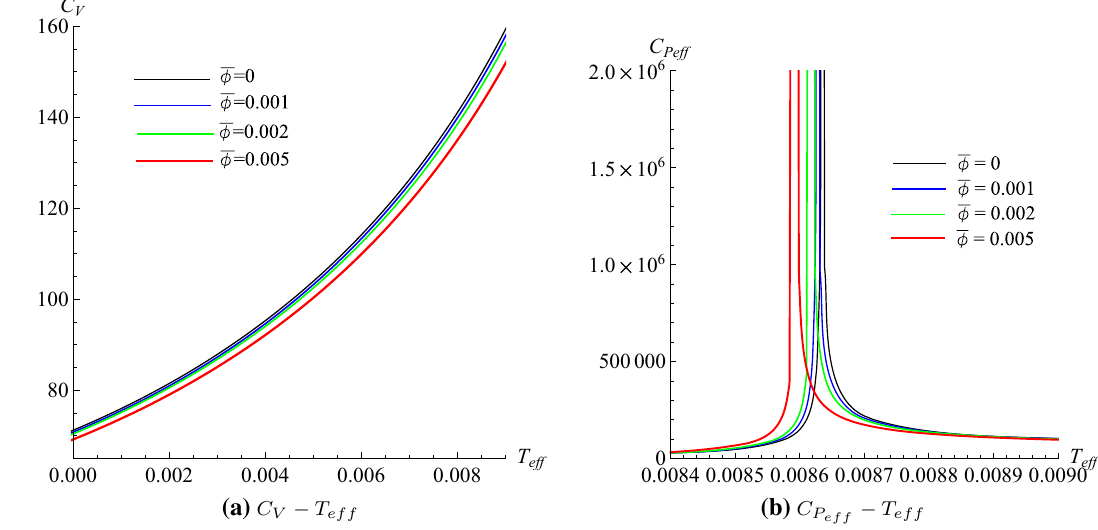
Fig. 3 The heat capacities as the functions of the effective temperature T ef f nearby the critical point with different non-linear correction for the parameters k = 1 , q = 1